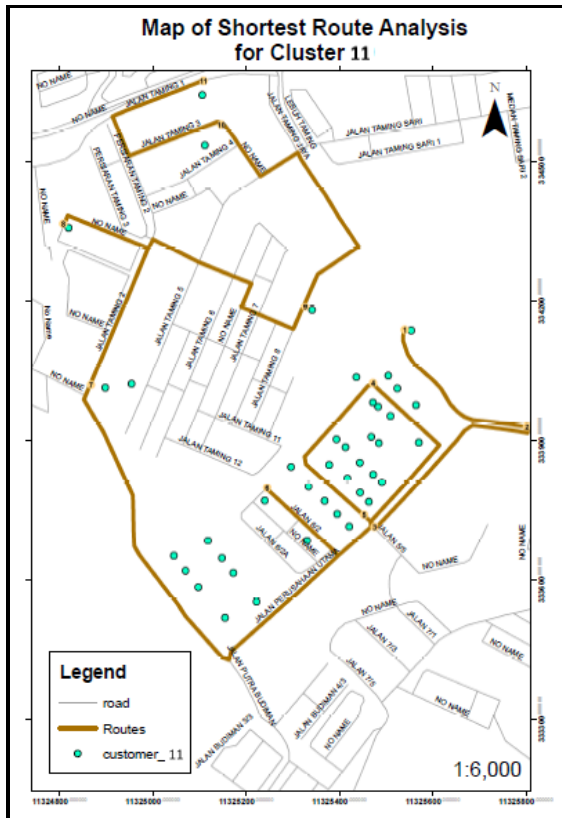
Figure12 One of the maps of cluster points